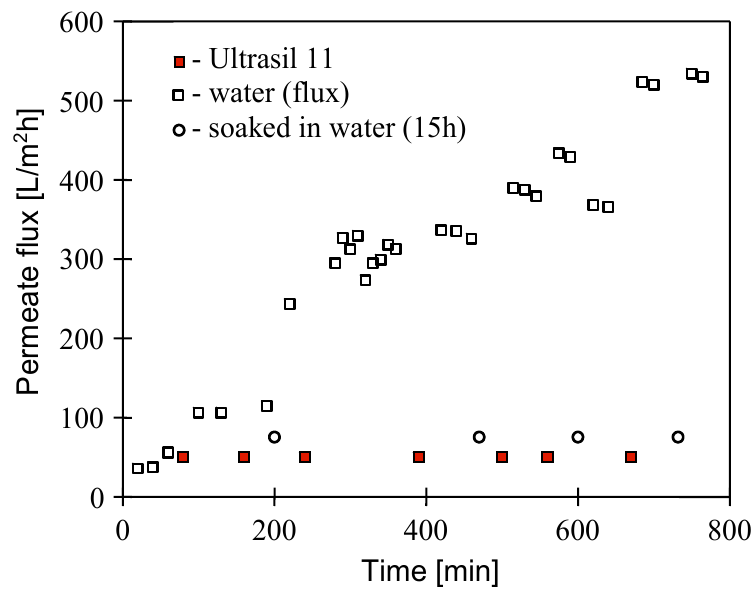
Figure 21. Variations in permeate flux during membrane cleaning with P3 Ultrasil 11 solution (1.5 g/L) after MF of oily wastewater #4.